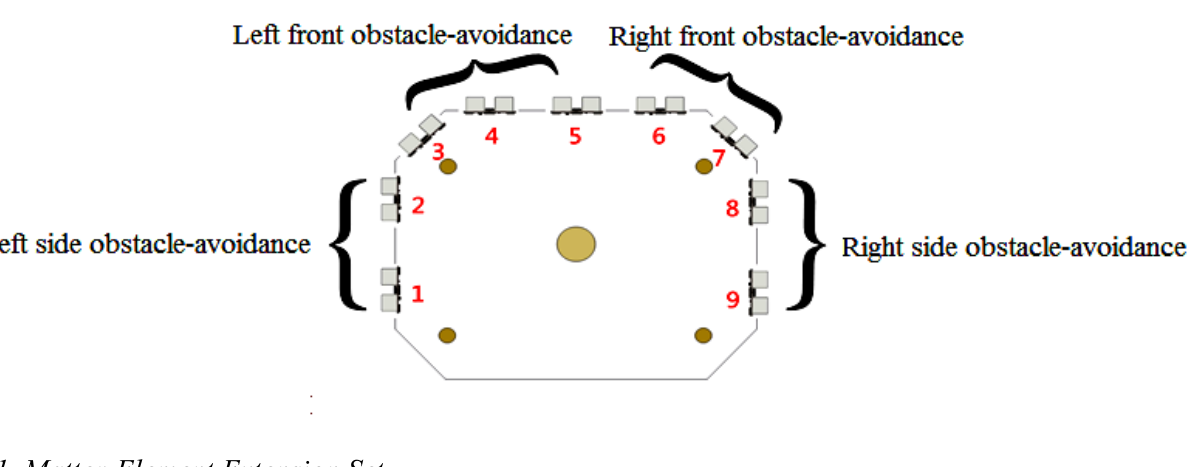
Figure 11. Ultrasonic distance sensors shown on the robot periphery.